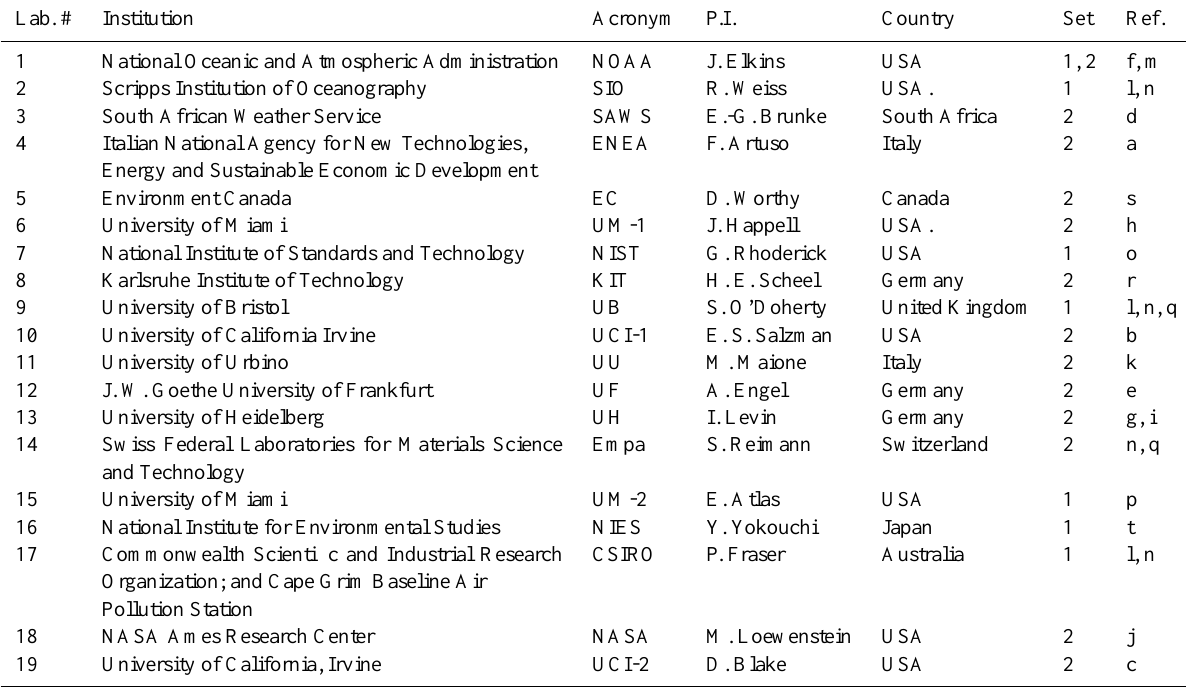
Table 1. List of participants and sample set analyzed (three cylinders in each set). Lab.